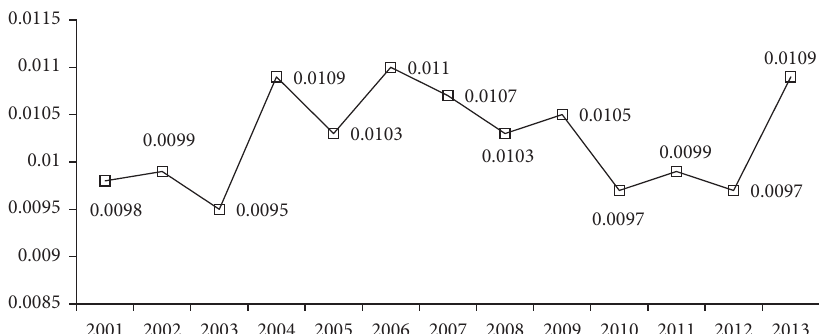
Figure 4: Evolution of clustering coefficient under directed weighted topology.